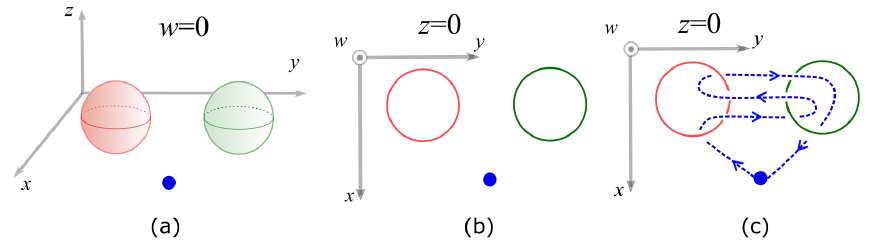
Figure 5 . Particle-membrane-membrane braiding described by AAC term. (a) Two membranes and one particle viewed in xyz -space with w = 0 . These two membranes are assumed to be static in space. (b) These two membrane excitations appears as two loops in xyw -space with z = 0 . (c) If viewed in xyw -space with z = 0 , the spatial trajectory of particle and two loops (projections of two membranes) form Borromean rings. In Borromean rings, any two of the two loops and particle’s trajectory are not linked. This means that the particle’s spatial trajectory is not linked with any of two membranes and neither the two membranes, which matches the exactness conditions that imply specific sub-manifolds are not linked. This particle-membrane-membrane braiding can be considered as the 5 D analog of particle-loop-loop braiding described by AAB term in 4 D